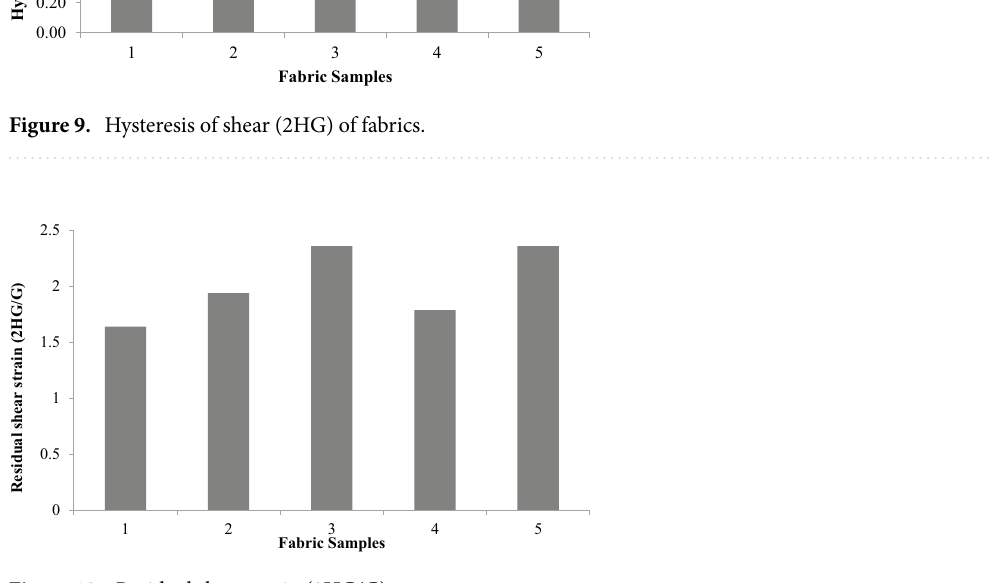
Figure 10. Residual shear strain